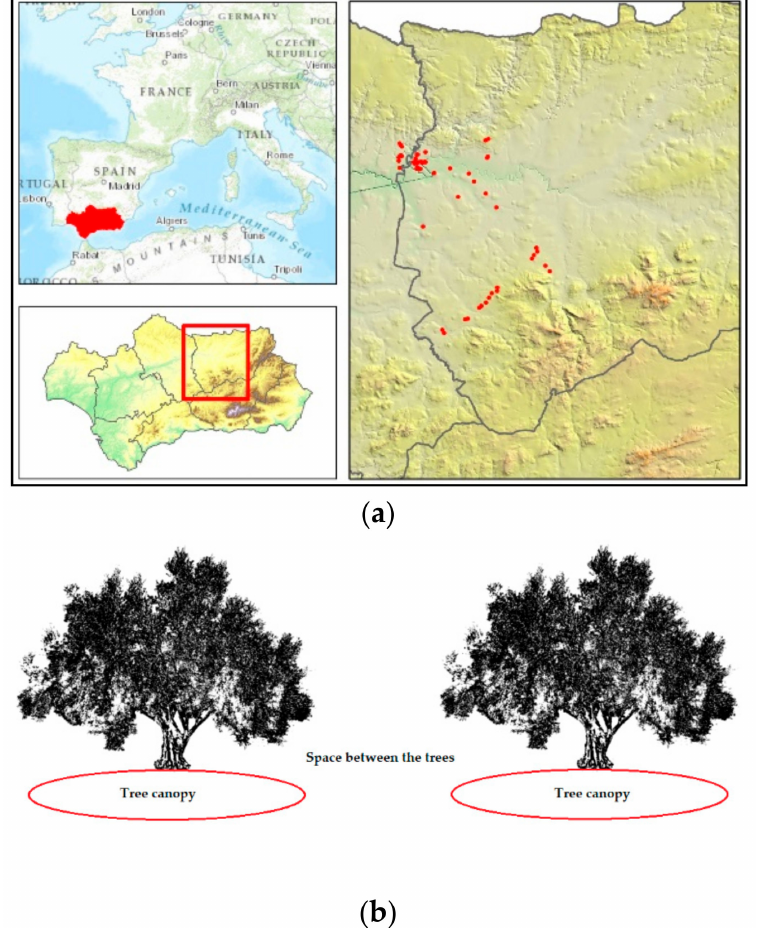
Figure 1. ( a ) Location of the area and sampling and resampling points. ( b ) Diagram with the arrange- ment of the olive trees. The projection of the tree canopy is called the ring, while the separation between the olive tree and the tree is the